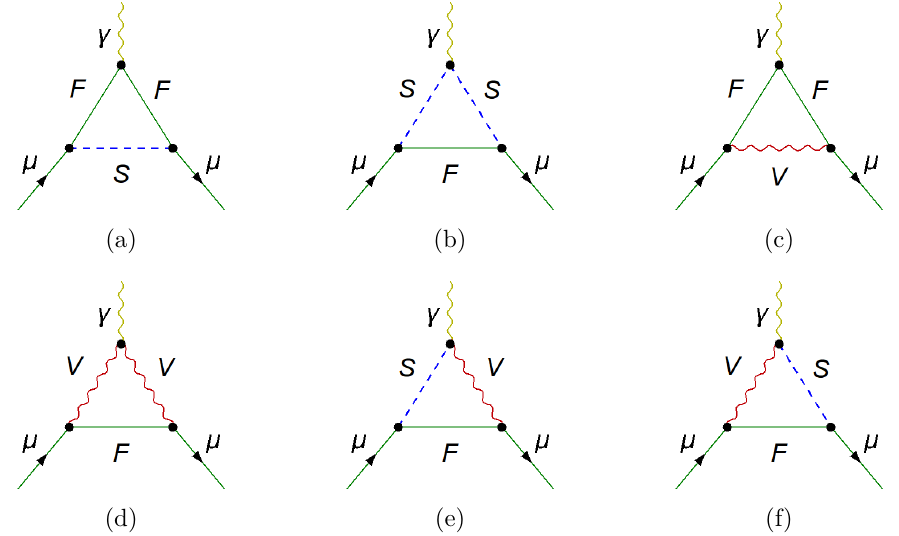
Figure 19. Diagrams producing general contributions to a µ . Reading left-to-right, top-to-bottom, the FFS diagram 19(a), the SSF diagram 19(b), the FFV diagram 19(c), the VVF diagram 19(d), the VSF diagram 19(e), and the SVF diagram